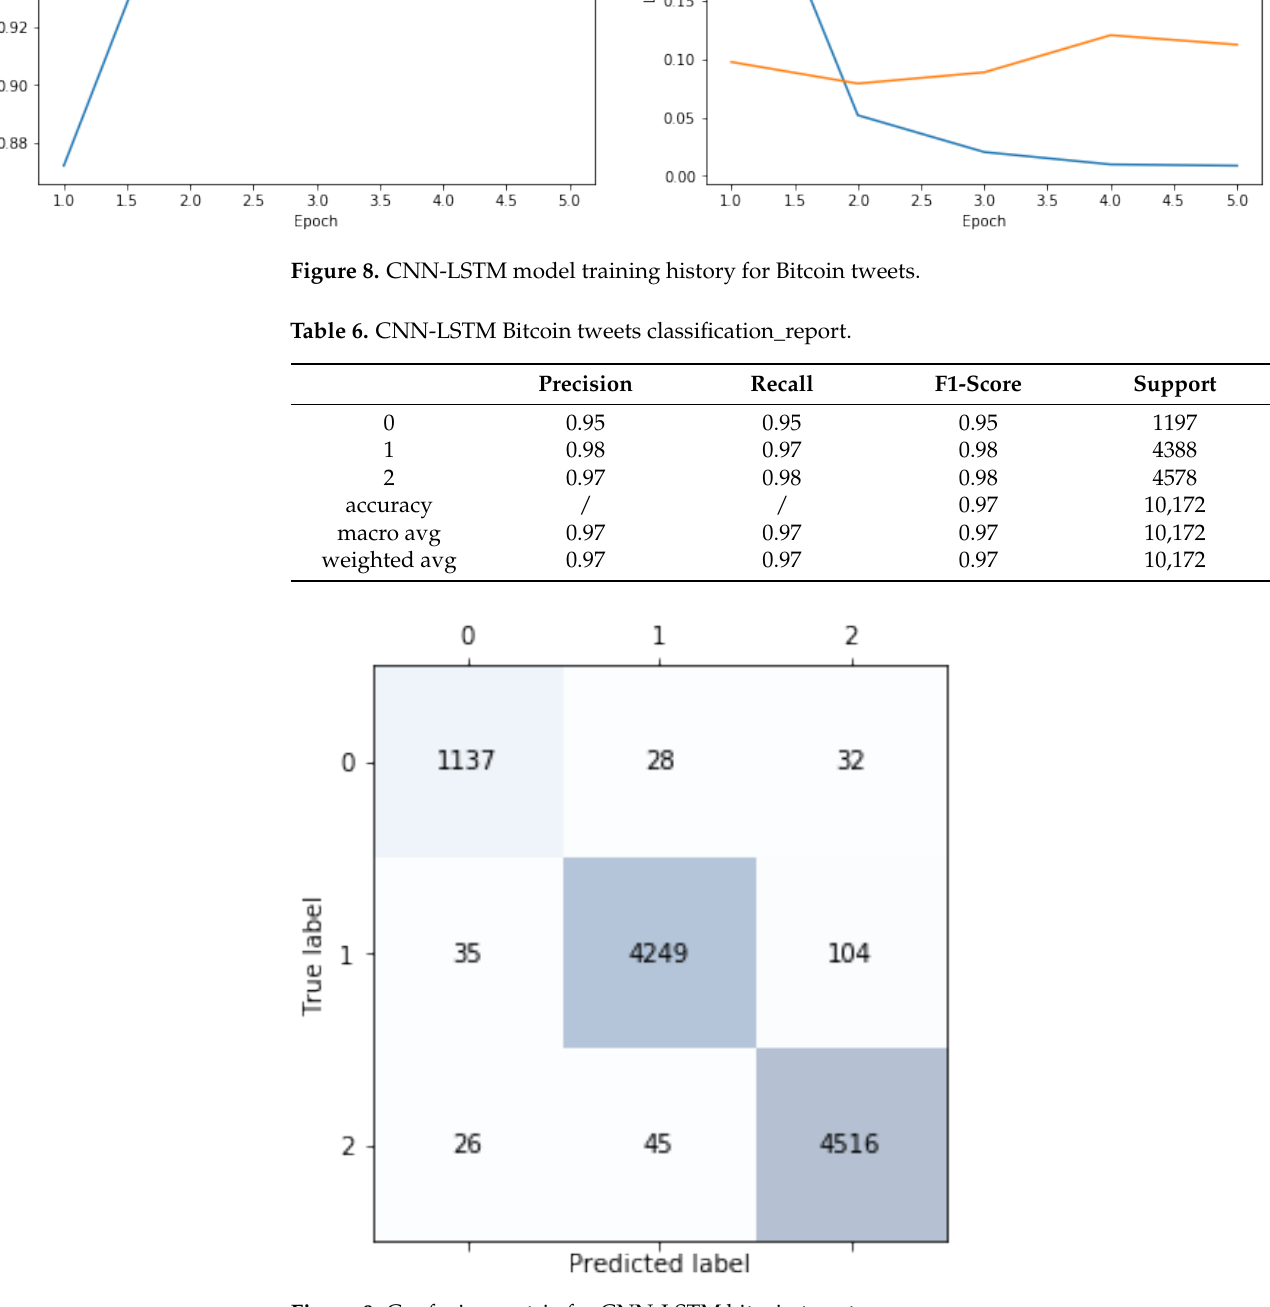
Figure 9. Confusion matrix for CNN-LSTM bitcoin tweets.